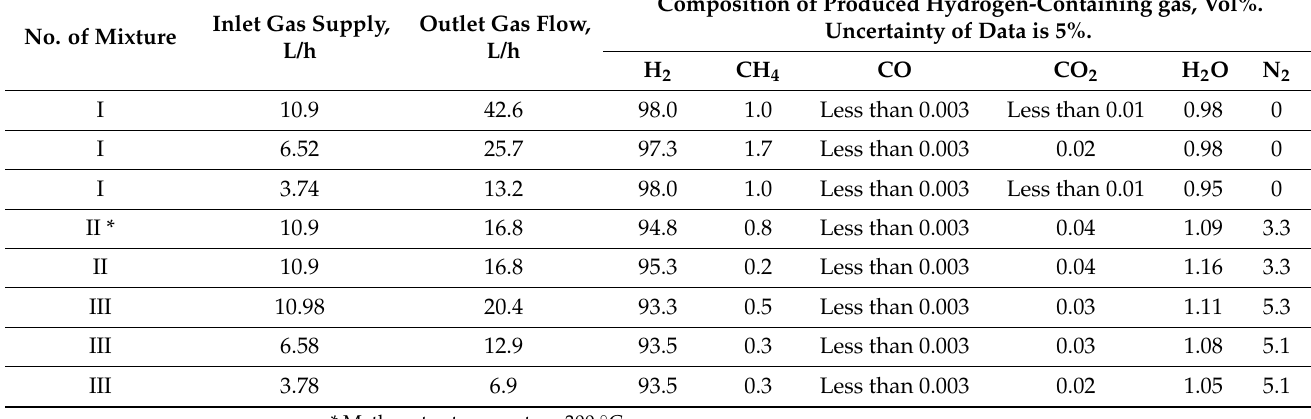
Table 4. Indicators of steam reforming of biogas.